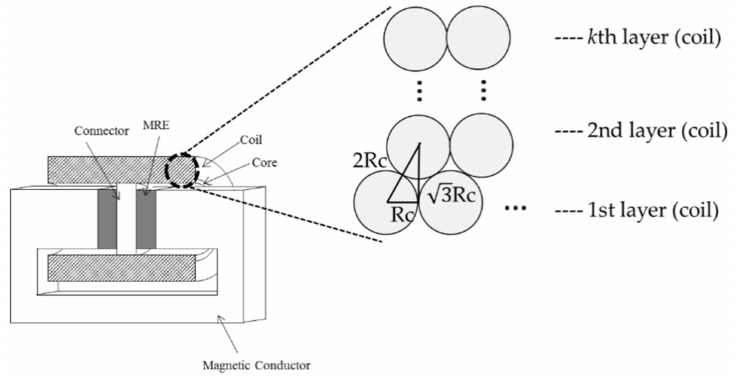
Figure 15. Cross section of coil